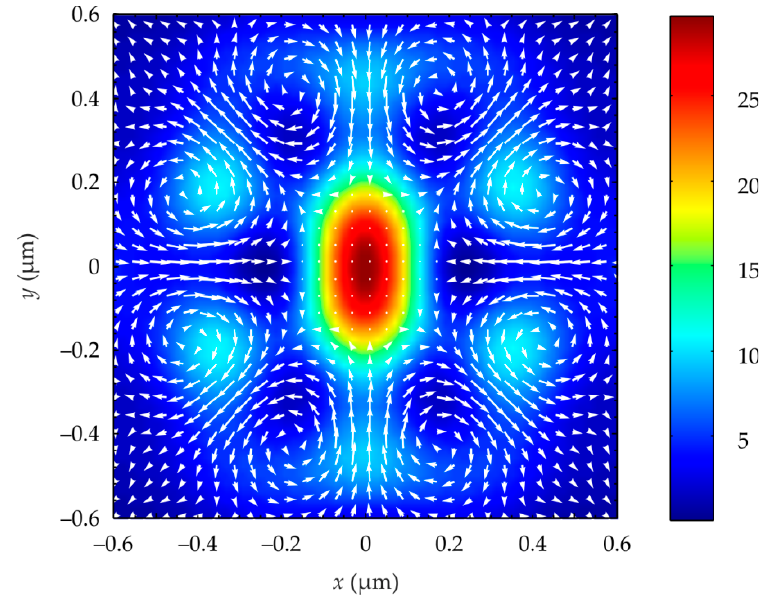
Figure 3. Intensity distribution and direction and magnitude (arrows) of the transverse energy flow P x i + P y j , calculated using (14), at the focus. P x i + P y j , calculated using (14), at the